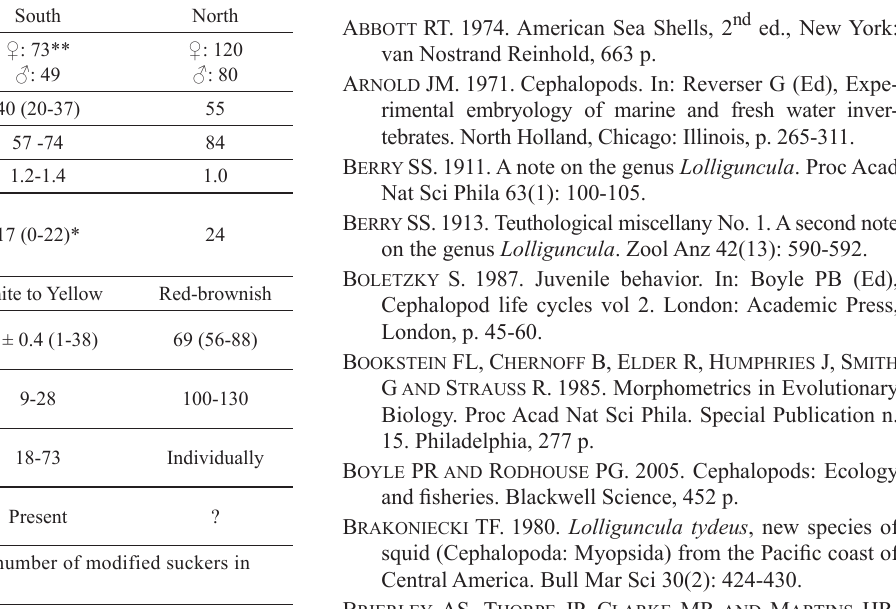
TABLE V ovos sugerem que Lolliguncula ocorrentes no hemis- Distinguishing features of Lolliguncula brevis from Northwest and férios norte e sul devam pertencer a táxons diferentes. Southwest Atlantic. Data of northern hemisphere specimens are from Roper et al. (1984), Voss (1956) and Hall (1970). Range indicated in parentheses. Data of southern hemisphere specimens are this study or ** of Simone